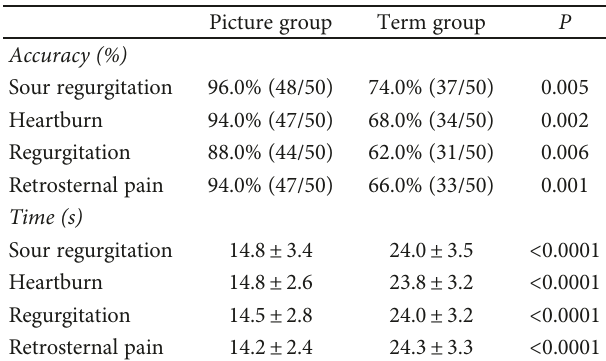
Table 2: Comparison of accuracy and timing between the two groups of the general